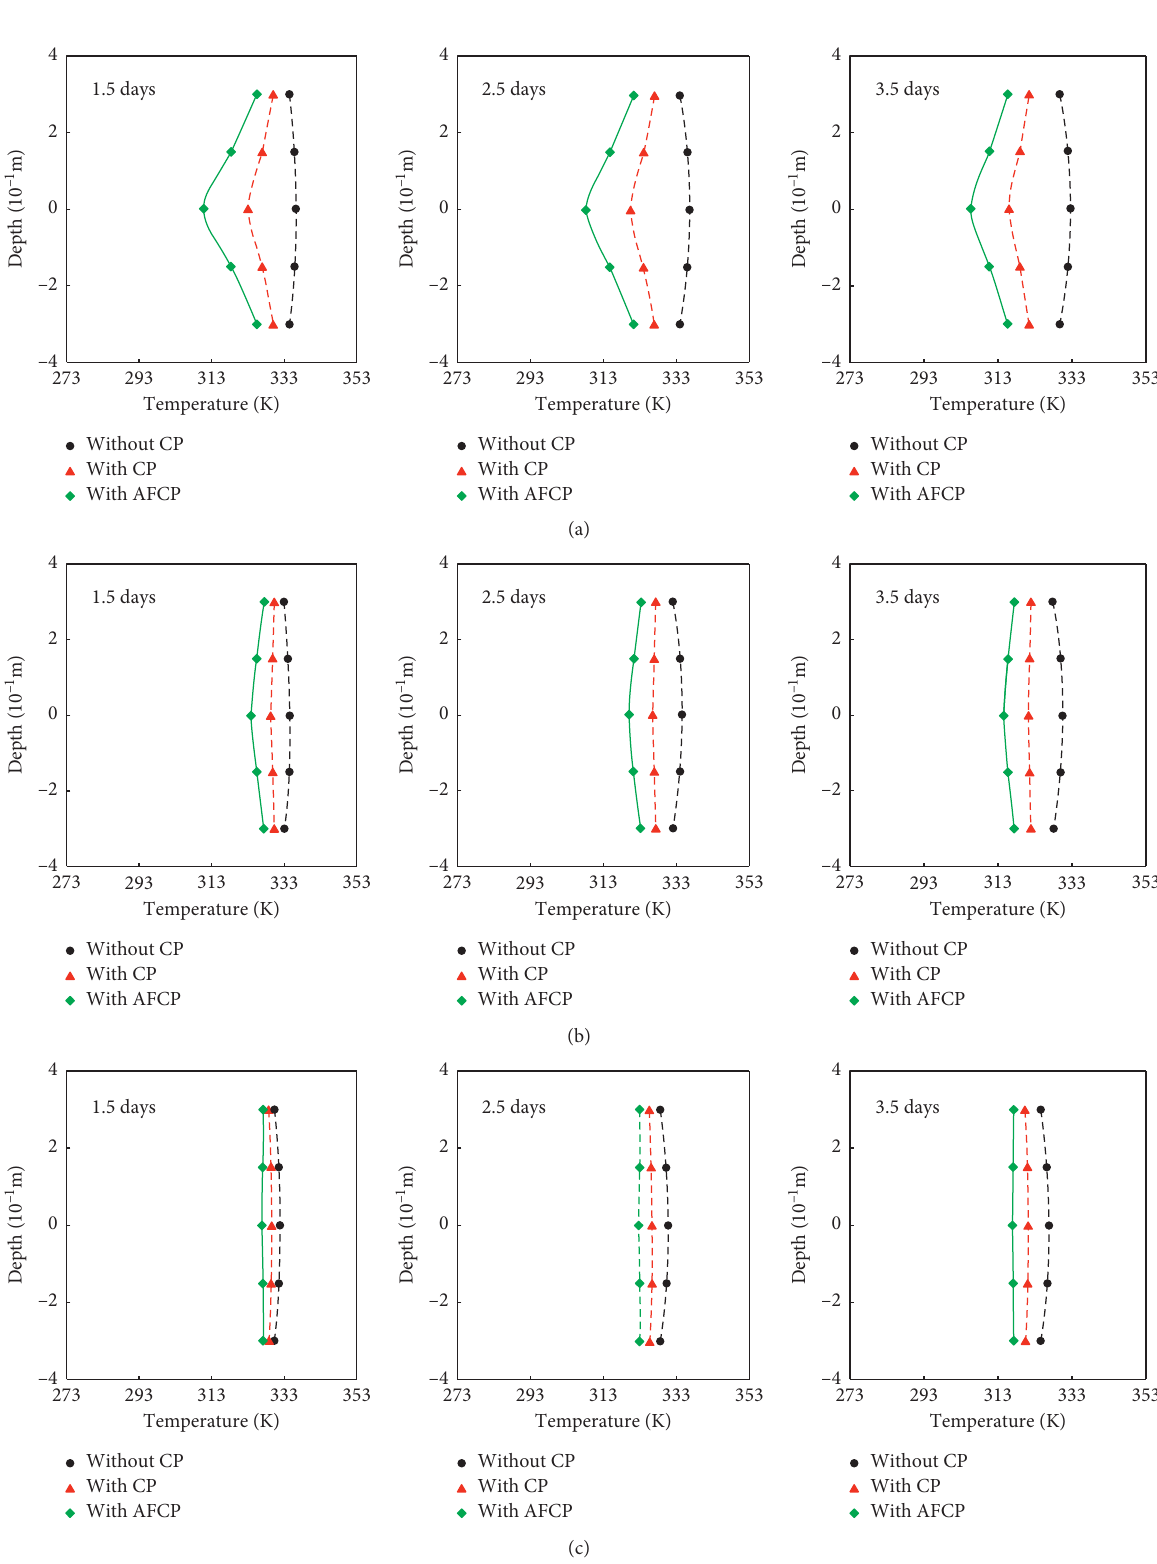
Figure 11: Temperature distribution of concrete at (a) section B, (b) section C, and (c) section